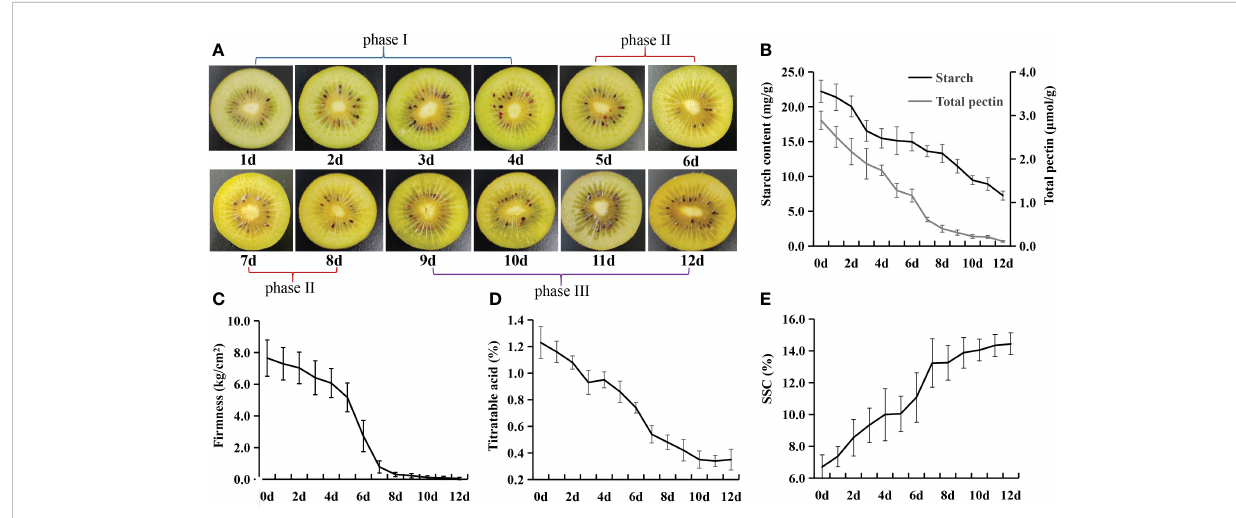
FIGURE 1 Twelve ripening stages at 20°C selected for analysis of Actinidia chinensis cv. Jinyan. (A) Color changes of fl esh during postharvest ripening. (B) Changes in starch and total pectin content during ripening. (C) Changes in fruit fi rmness during ripening. (D) Changes in percentage of titratable acid during ripening. (E) Changes in soluble solid concentration (SSC) during